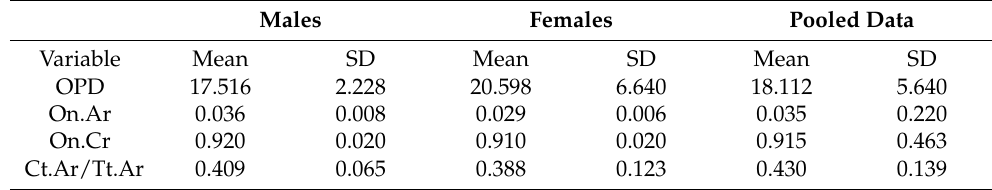
Table 5. Descriptive statistics for the histomorphometric variables of the rib sample divided by